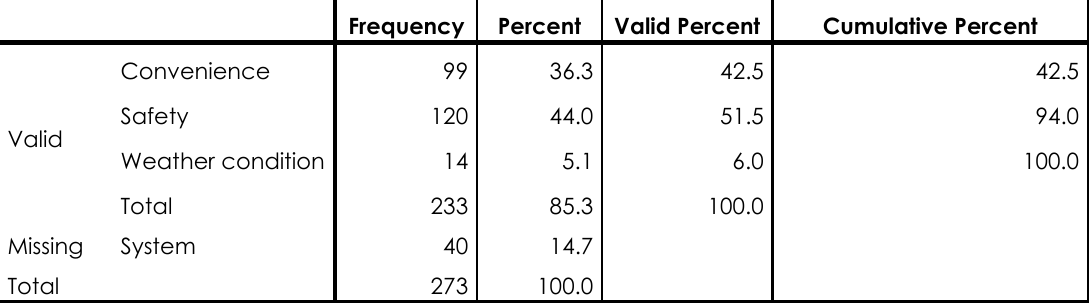
Table 4: Parent Preference on Automobile Trips to